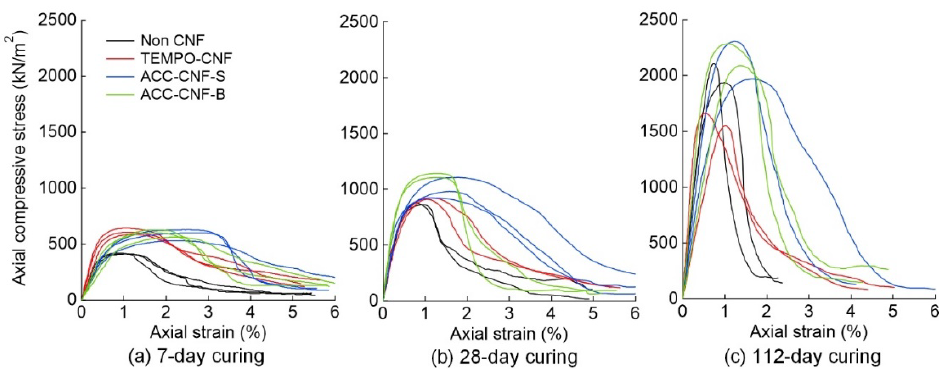
Figure 5. Relation between stress and strain in unconfined compression tests (Method 1).